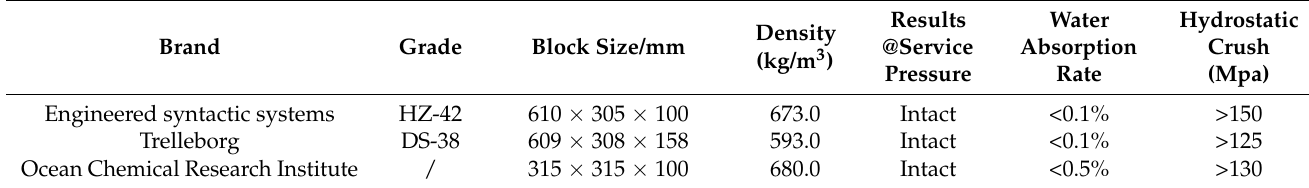
Figure 7. ( a ) Water absorption rate; ( b ) density of buoyancy foam blocks.